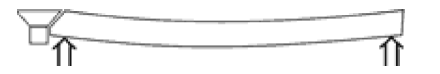
Fig. 8. A scheme illustrating how the sagging in the roof wors- ens the runoff